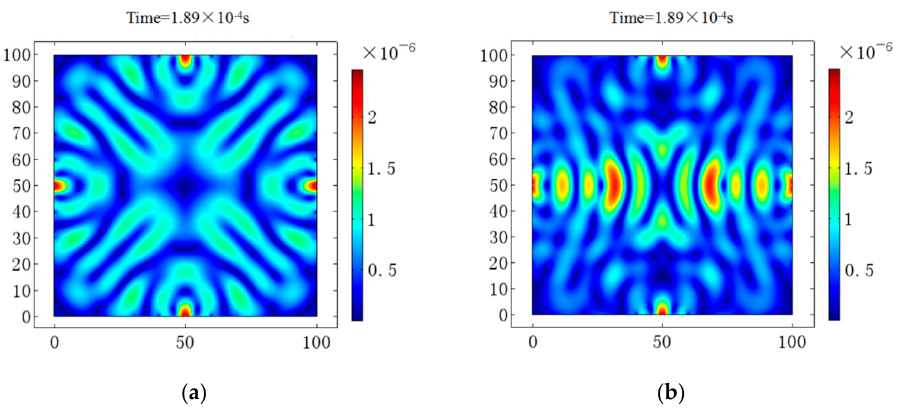
Figure 13. Imaging results. ( a ) Intact section image. ( b ) Damaged section image.